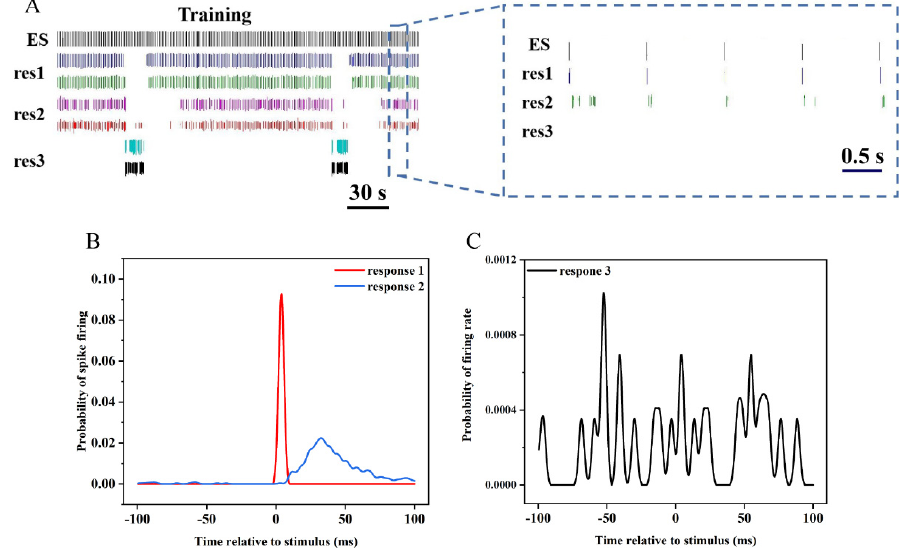
Figure 6. Responses of hippocampal neurons to electrical stimulation. ( A ) Three kinds of representa-tive spike trains of neuronal responses to stimuli during electrical stimulation training. ( B ) The PSTH of two effective responses of neurons to electrical stimulation. ( C ) The PSTH of ineffective responses of neurons to electrical stimulation.